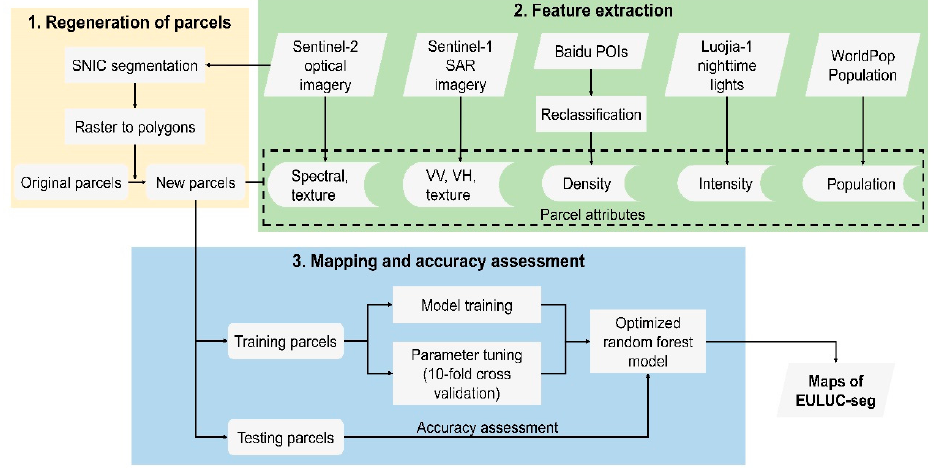
Figure 1. Workflow of the proposed mapping scheme.